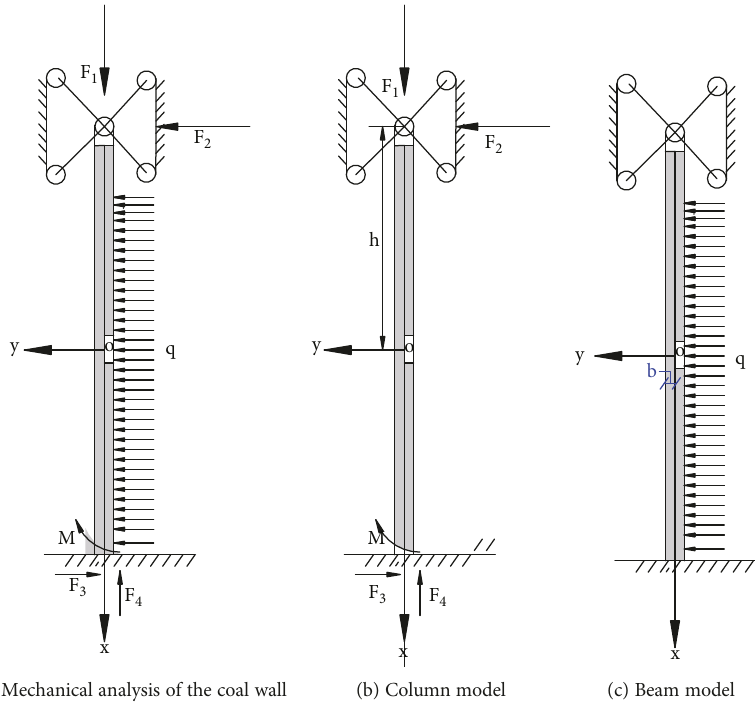
Figure 1: Mechanical